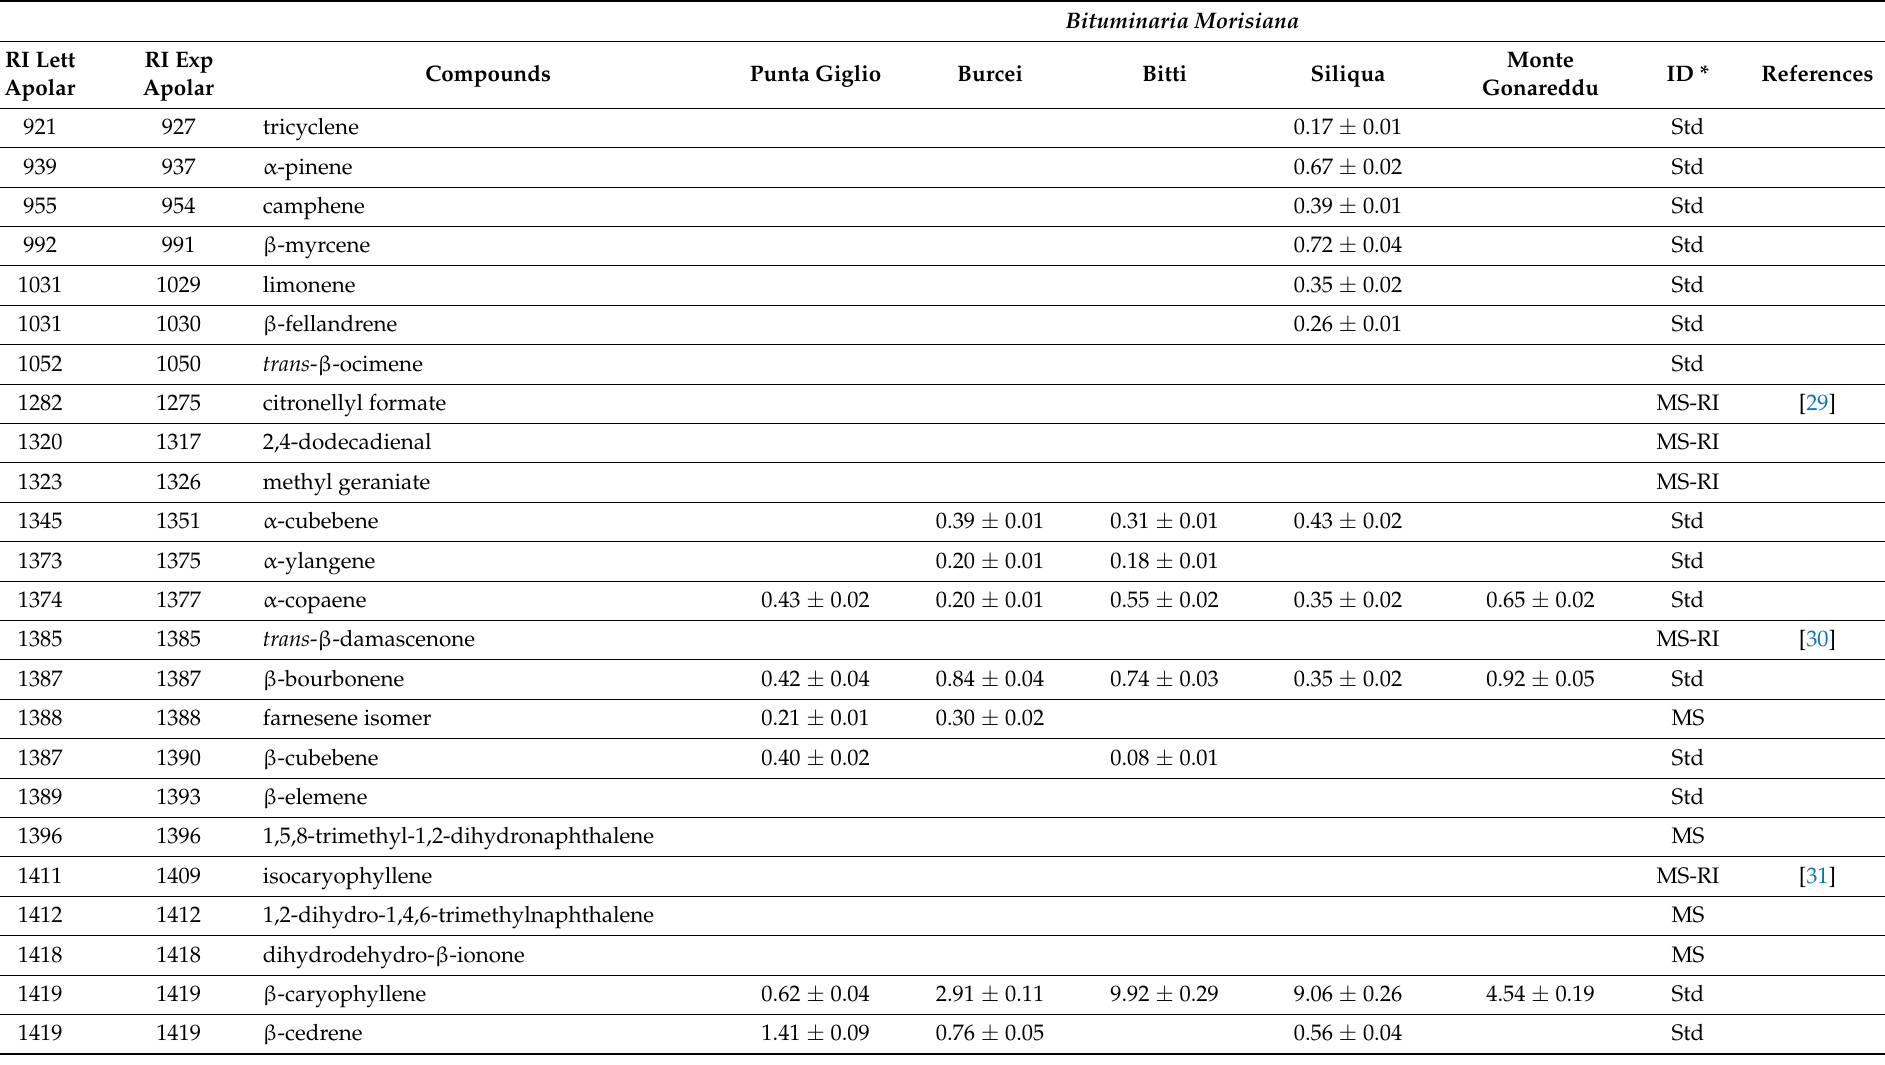
Table 3. Chemical composition of Sardinian endemic Bituminaria morisiana (Pignatti & Metlesics) Greuter essential oils growing up in a Sardinian experimental field. RI Lett Compounds Punta Giglio Burcei Bitti Siliqua